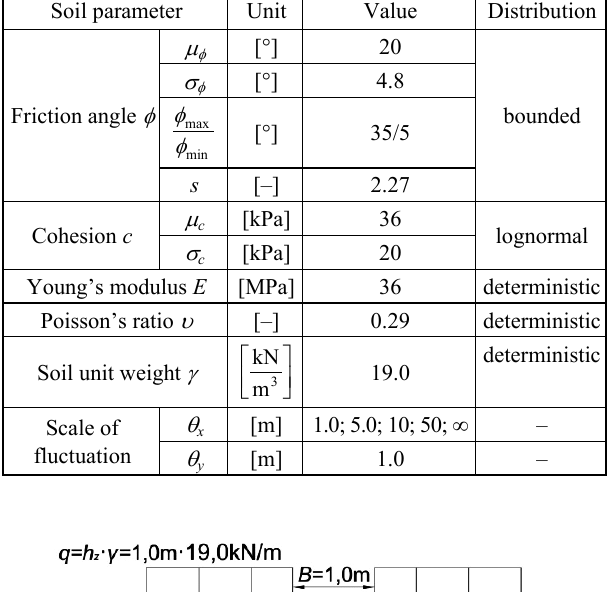
Table. 10. Soil parameters used in numerical analysis of the bearing capacity of cohesive soil